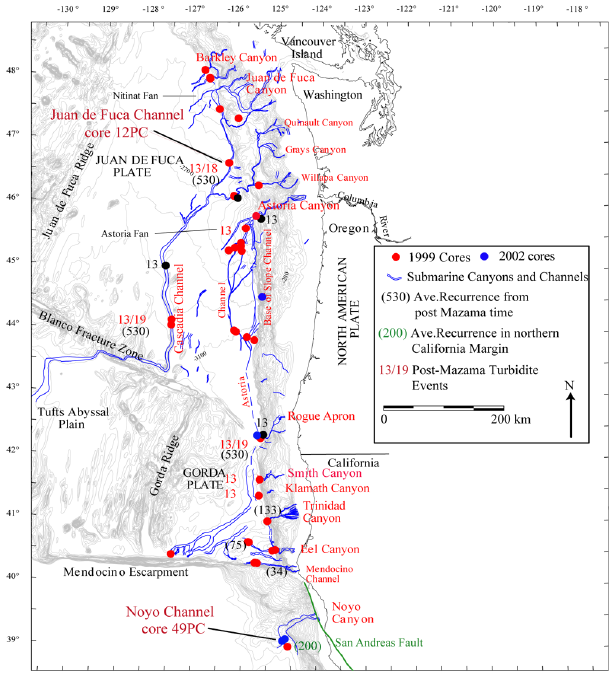
Fig. 1. Geological setting of the Cascadia active tectonic continen- tal margin associated with the Cascadia subduction zone, which is made up of the Juan de Fuca and Gorda plates. Cascadia and northern California margins canyons, channels, 1999–2002 core lo- cations, and main fault systems are outlined. The pathways of the major canyons are shown in blue, and the number of correlated post- Mazama and Holocene turbidites are shown in red. See an example of the Mazama ash datum in Fig. 4. Mazama ash was not present in northern Barkley Canyon cores or in the cores south of Rogue Canyon. Note location of the Juan de Fuca channel core in Fig. 4. (Figure is modified from Goldfinger et al.,